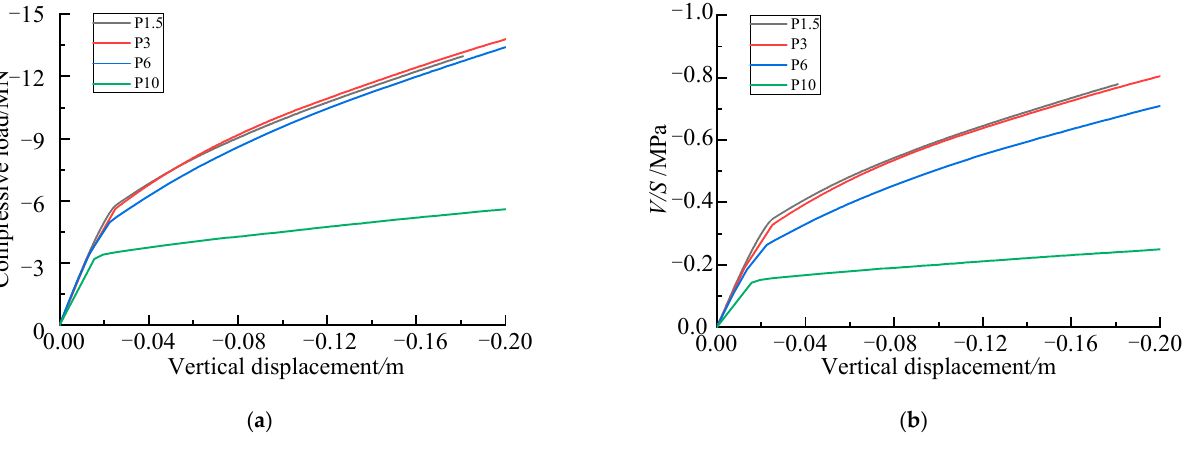
Figure 16. Compression bearing characteristics curves. ( a ) Load-displacement curves; ( b ) V/S -displacement curves.